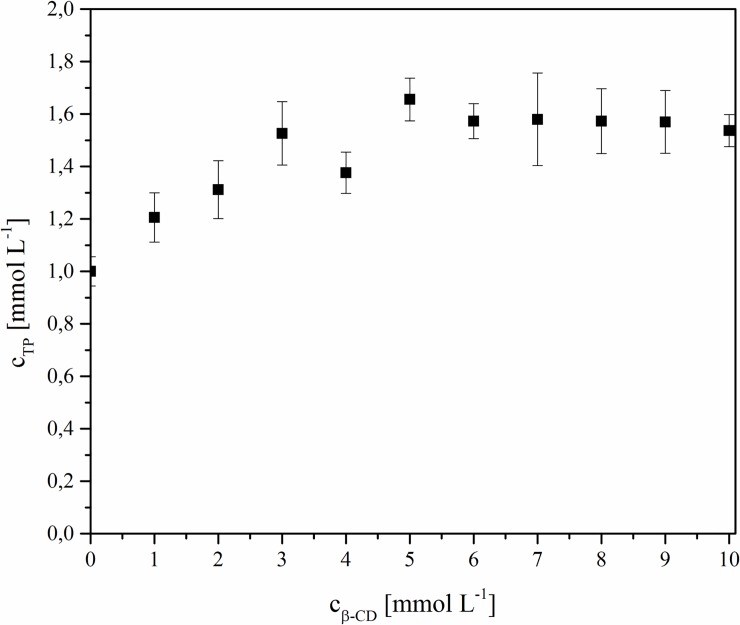
Phase-solubility diagram of TP inclusion complex in water.